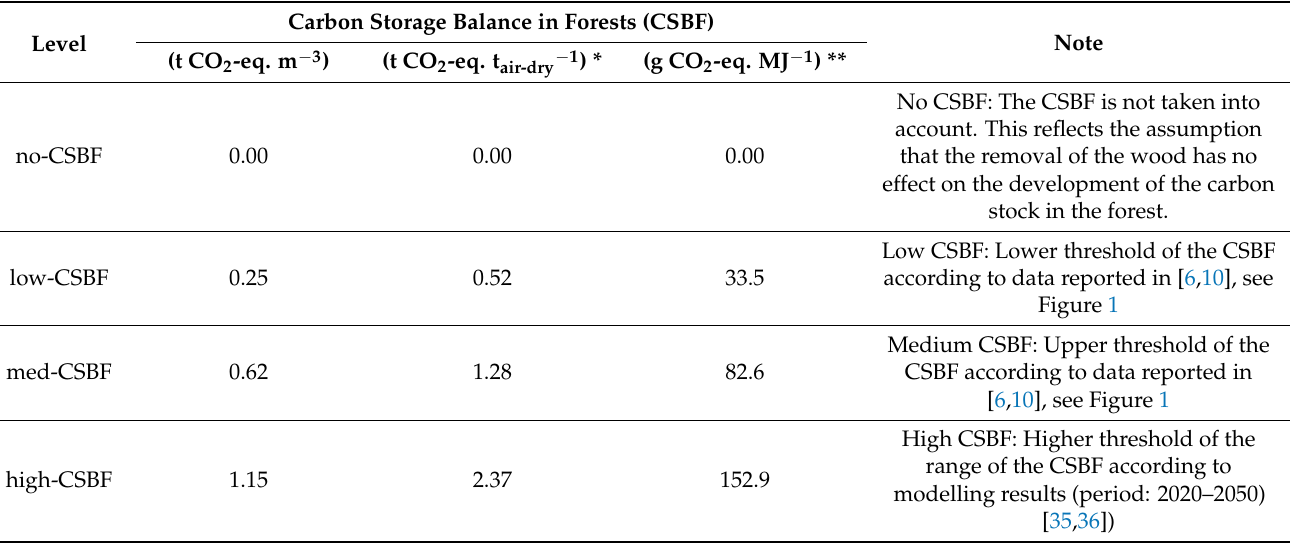
Table 3. Carbon storage balance in forests (CSBF) for removed wood.